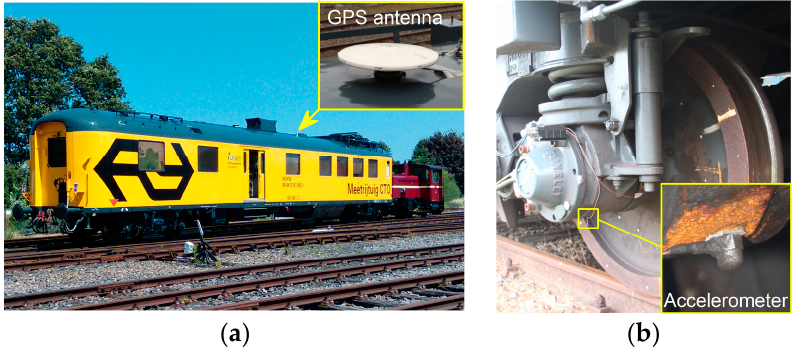
Figure 4. ( a ) Axle box acceleration (ABA) measuring train and ( b ) accelerometer configuration.